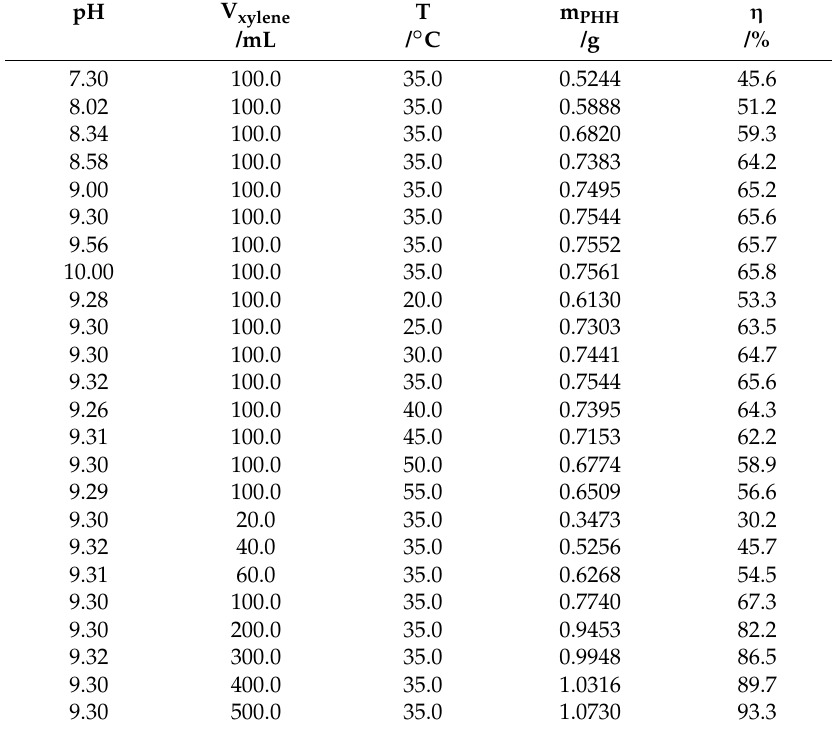
Table 2. Experimental data in the extraction process at lab